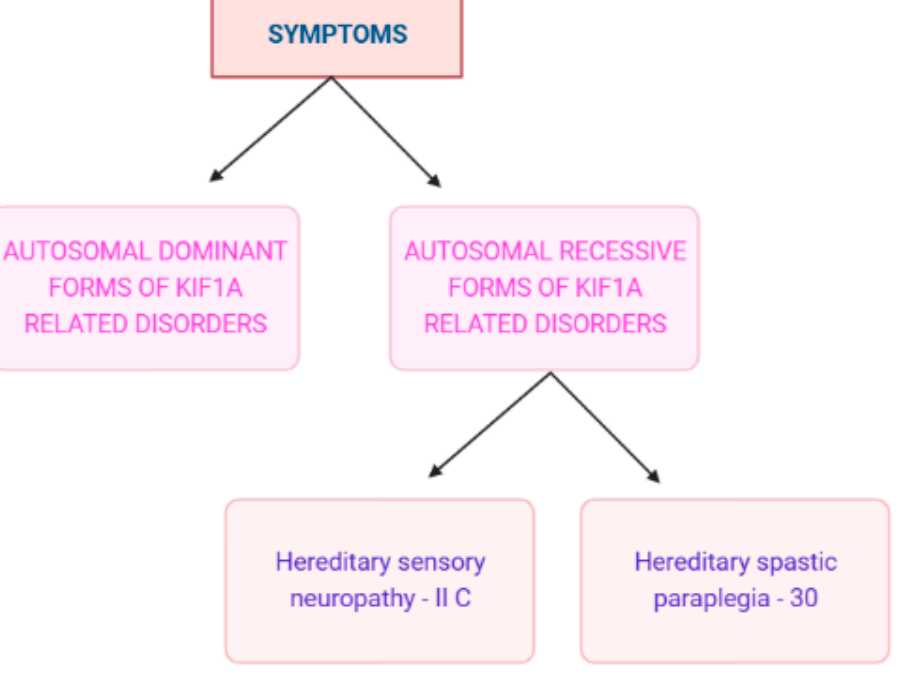
Figure 4. KAND symptoms on a clinical basis [36]. II C is a type of autosomal recessive disorder and can be represented as 2C also. (Created with